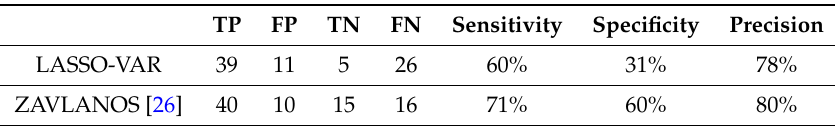
Table 2. Comparisons of the inferred network for the SOS pathway in E. coli using LASSO-VAR and Zavlanos’ method. TP FP TN FN Sensitivity Specificity